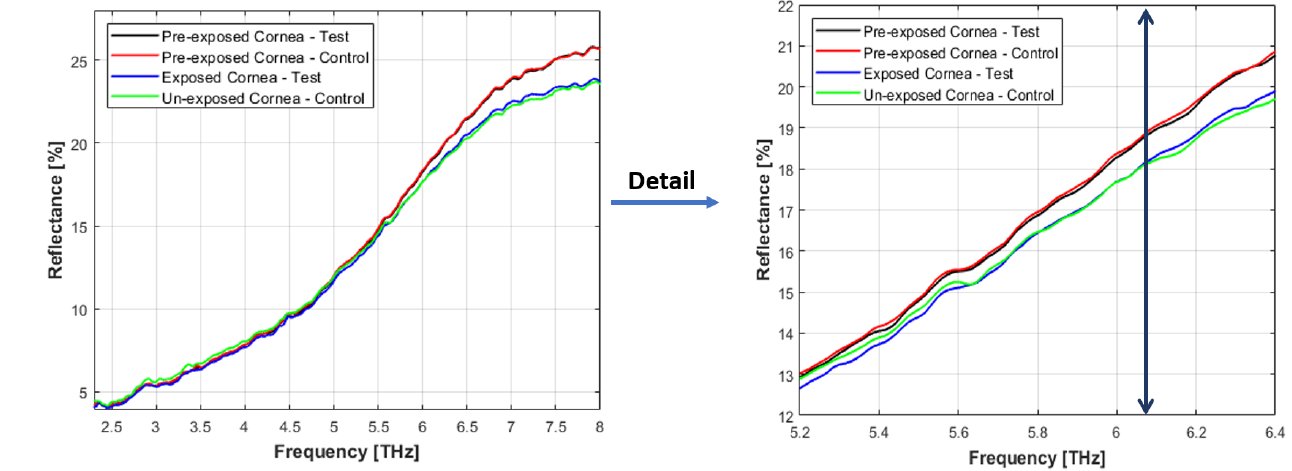
Figure 4. ( Left ) Reflectance data for porcine exposed and unexposed corneal tissues in the THz range (2.4 to 8 THz) corresponding to (79.92 to 266.4 cm − 1 wavenumber). The data were normalised